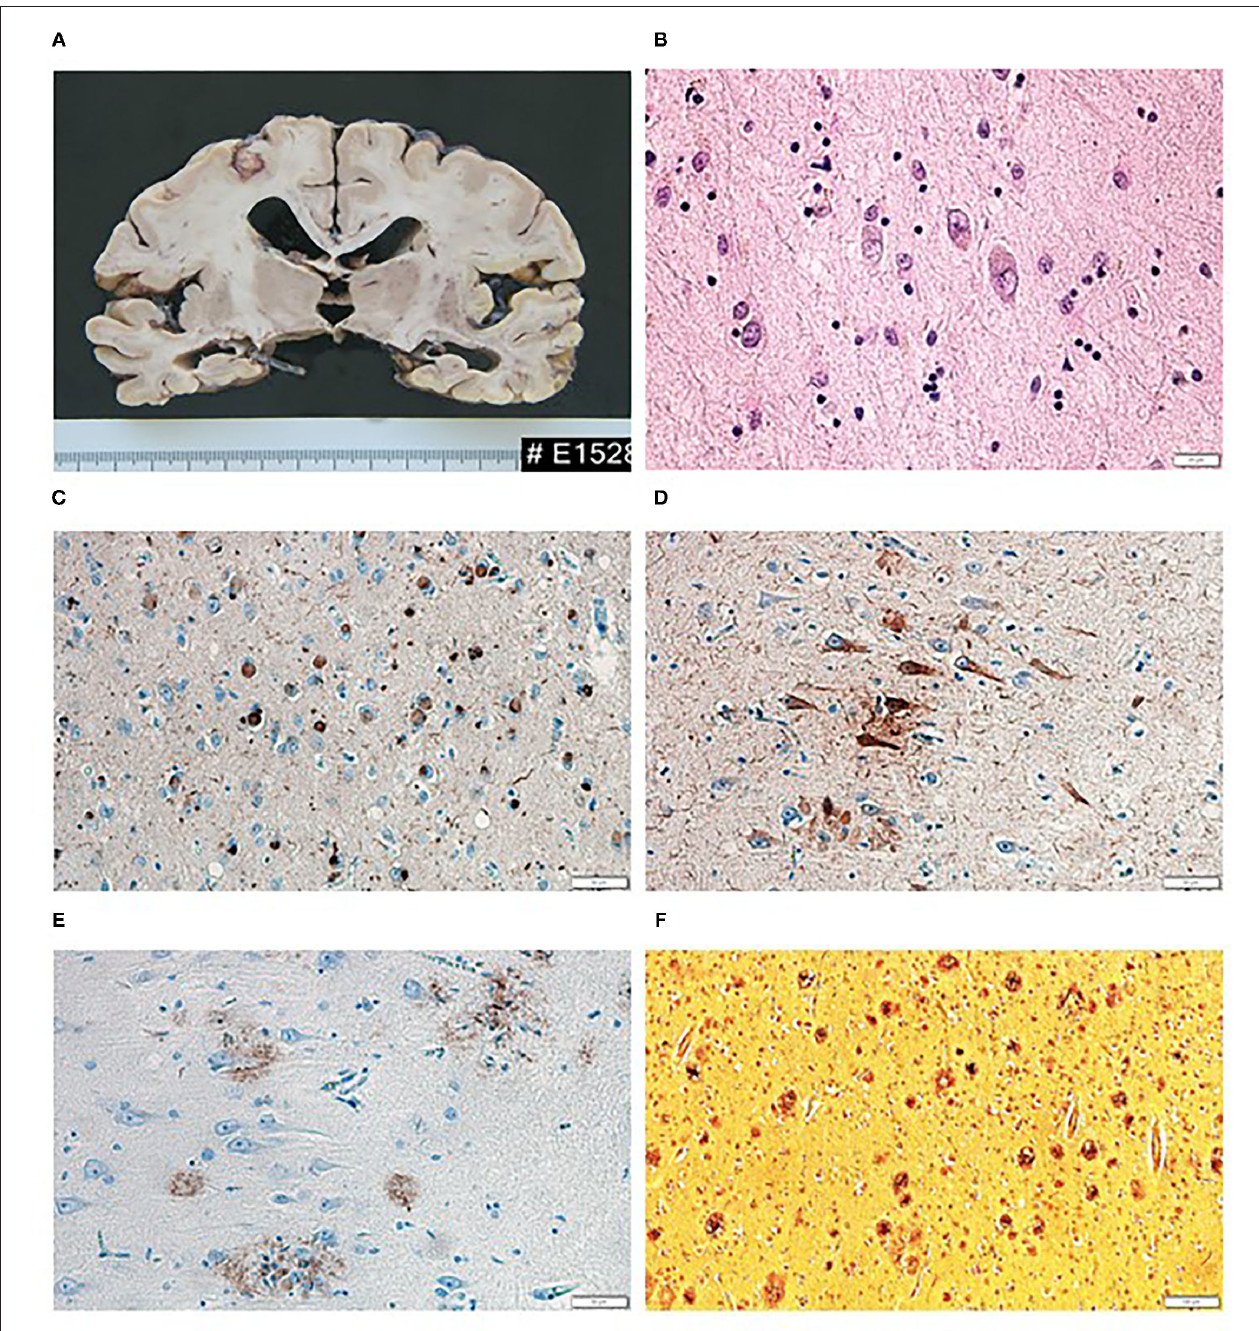
FIGURE 2 | Macroscopic and microscopic findings of histopathological examination of brain tissue. (A) Diffuse brain atrophy with the compensatory dilatation of the lateral and third ventricles; the atrophy was most pronounced in the frontotemporal regions, particularly in medial temporal lobes. (B) Lewy bodies in the neurons of the amygdala (HandE, magnification 400 × ). (C) Lewy bodies, dystrophic Lewy neurites and dots in the amygdala ( α -syn 5G4, magnification 200 × ). (D) Neurofibrillary tangles and threads in the hippocampus (AT8, magnification 200 × ). (E) β -amyloid deposits in the hippocampus ( β -amyloid, magnification 200 × ). (F) Plaques in the frontal cortex (AgNOR, magnification 100 ×